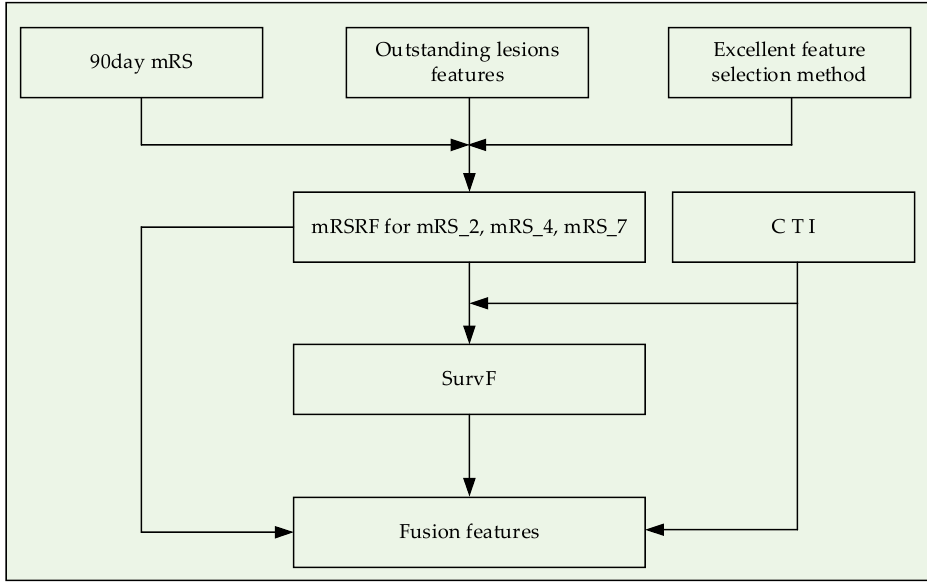
Figure 3. Flowchart of multidimensional feature fusion.